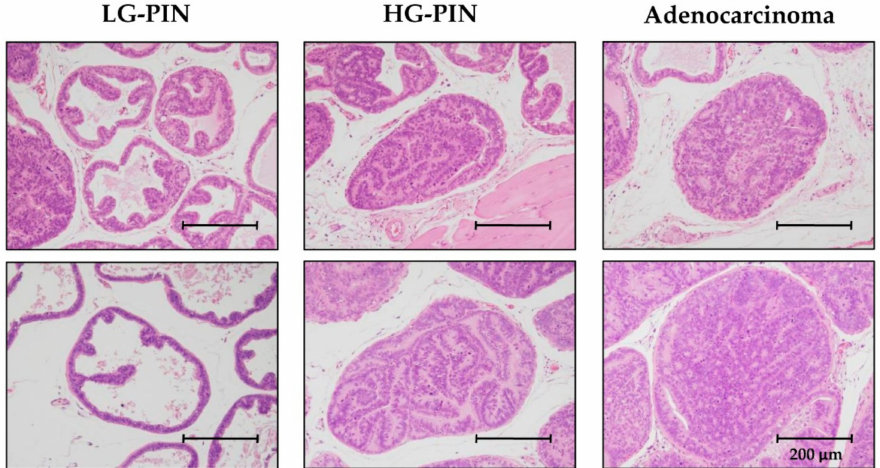
Figure 1. Prostatic proliferative lesions that were divided into 3 types: low grade (LG-PIN), high-grade prostatic intraepithelial neoplasia (HG-PIN), and adenocarcinoma (Magnification, 200 × ; scale bar, 200 µ